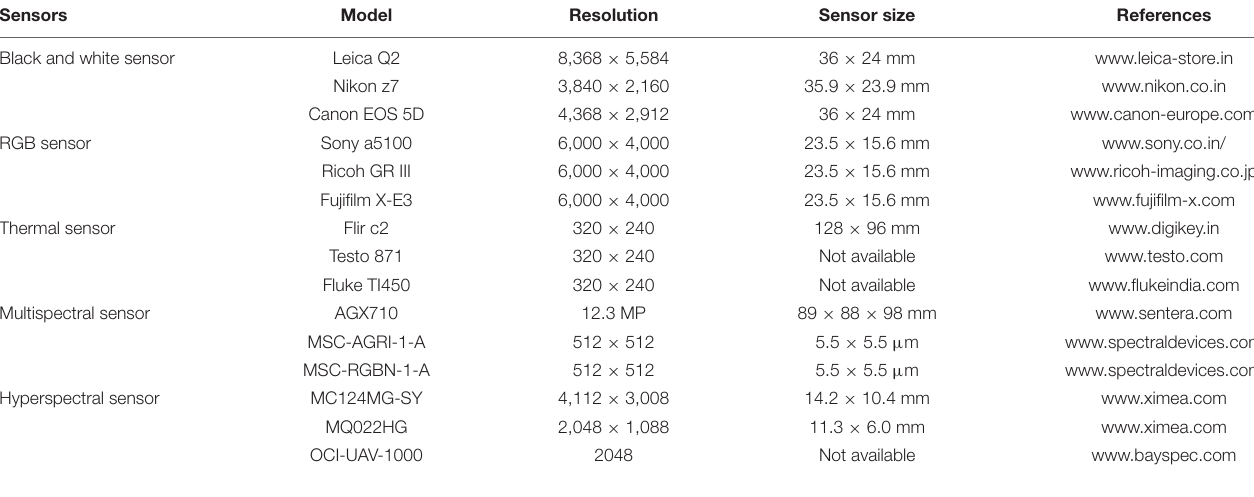
TABLE 2 | Different types of camera models available on the market.